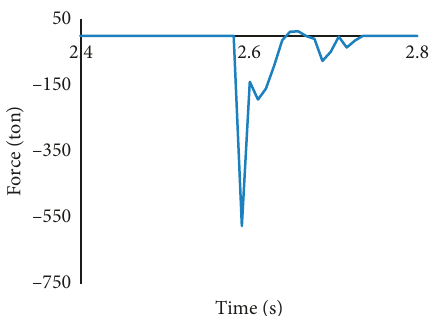
Figure 14: Impact force due to collision of deck with